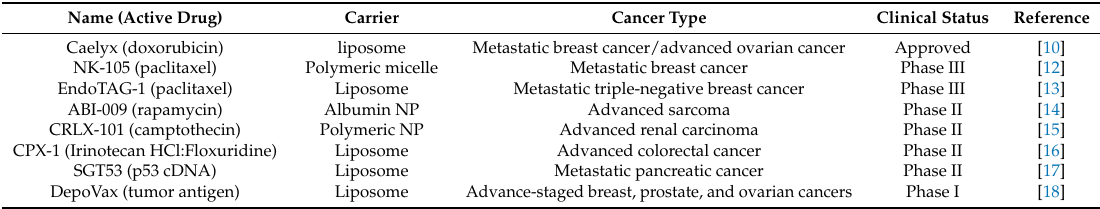
Table 2. Nanomedicines in clinical trials for treating advanced-stage cancers. The targeting strategy for all cases in passive.